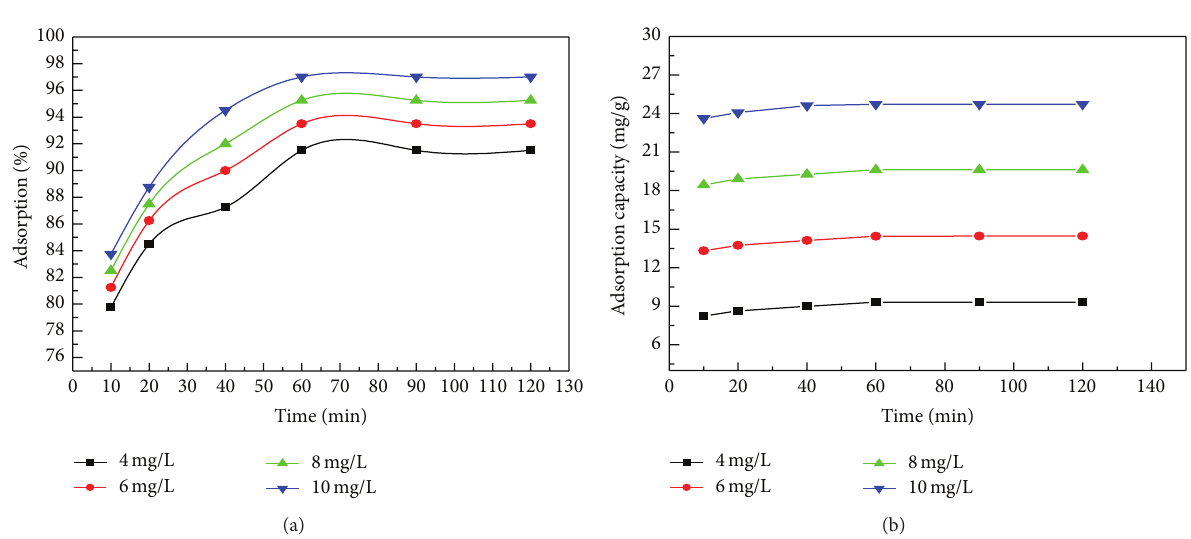
Figure 5: (a) Effect of contact time on adsorption of MB on C. polygonoides ash. (b) Adsorption capacity plot for adsorption of various concentration of MB on C. polygonoides